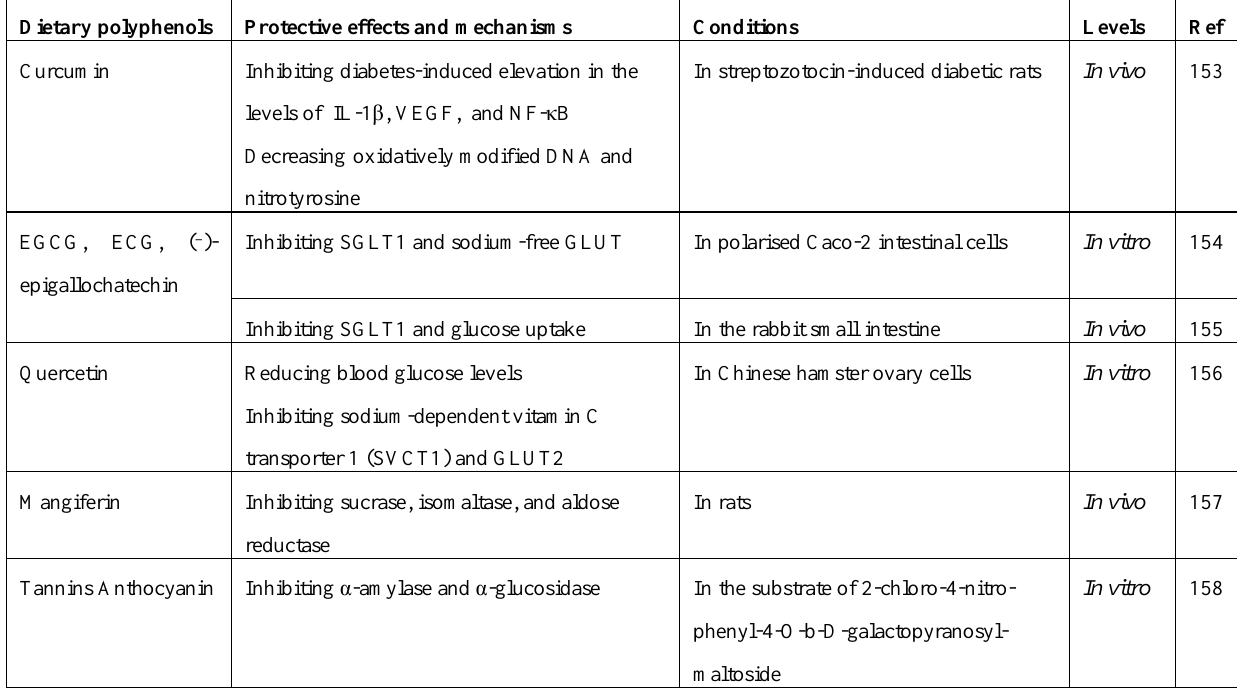
Table 9. Antidiabetic activity of dietary